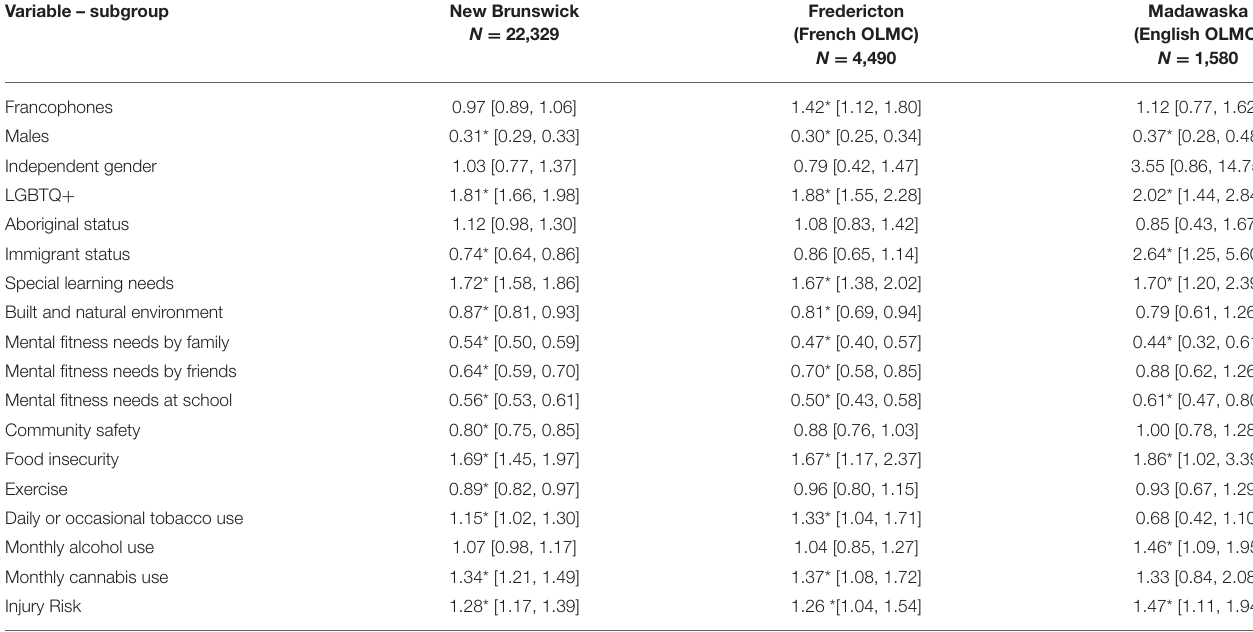
TABLE 2 | Odds ratios and 95% C.I. for symptoms of anxiety for New Brunswick and two OLMCs. Variable – subgroup